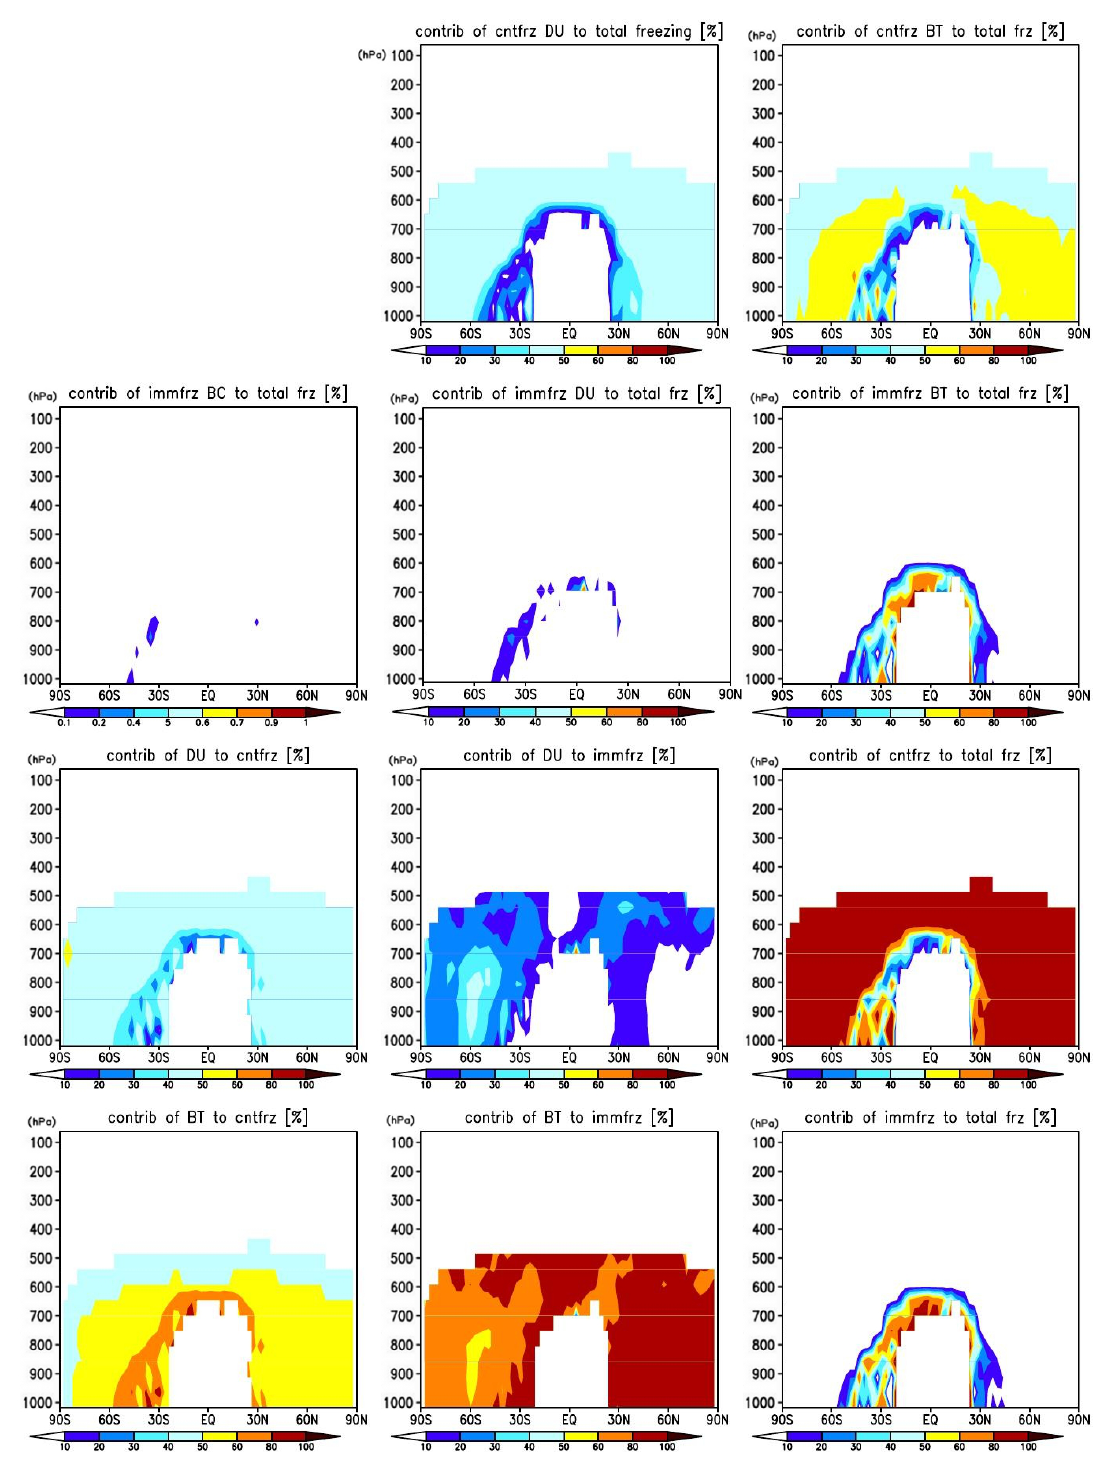
Fig. 9. Modelled annual zonal mean latitude vs. pressure cross sections of the percentage fraction of the different freezing mechanisms from simulation BT10 for bacteria, mineral dust and black carbon. Please note the different scale for black